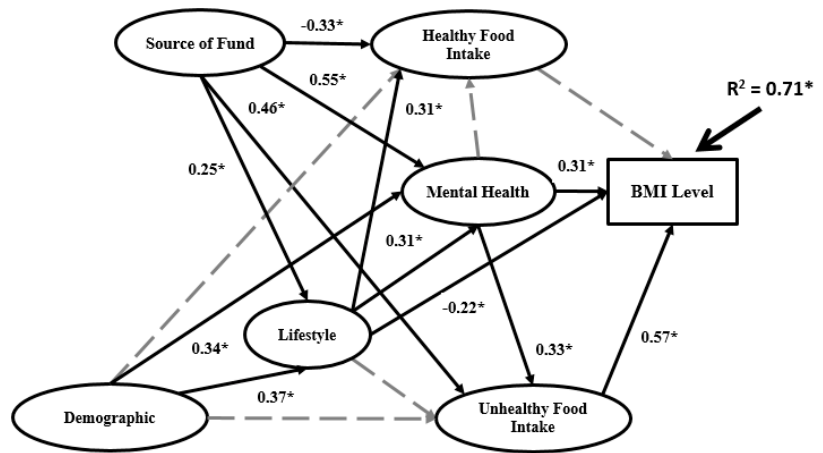
Figure 6. Final BSEM outputs of the Master model.